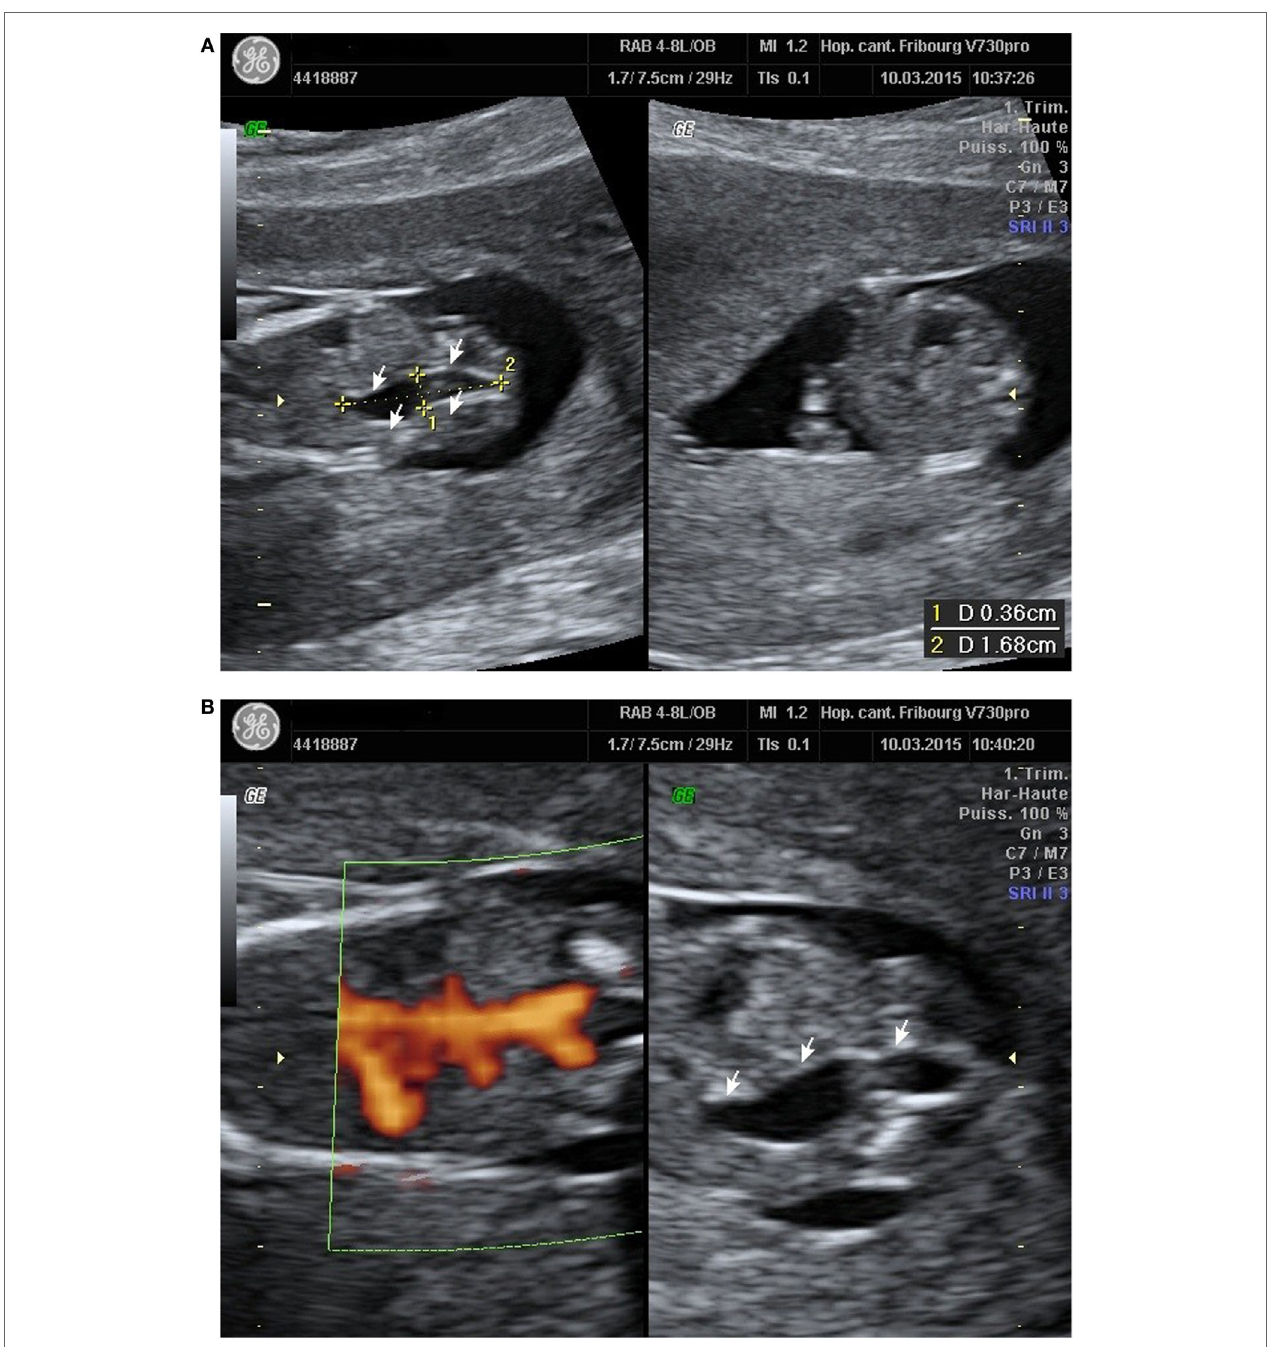
FIGURe 1 | (a) Right ureteral dilatation. (B) Doppler renal